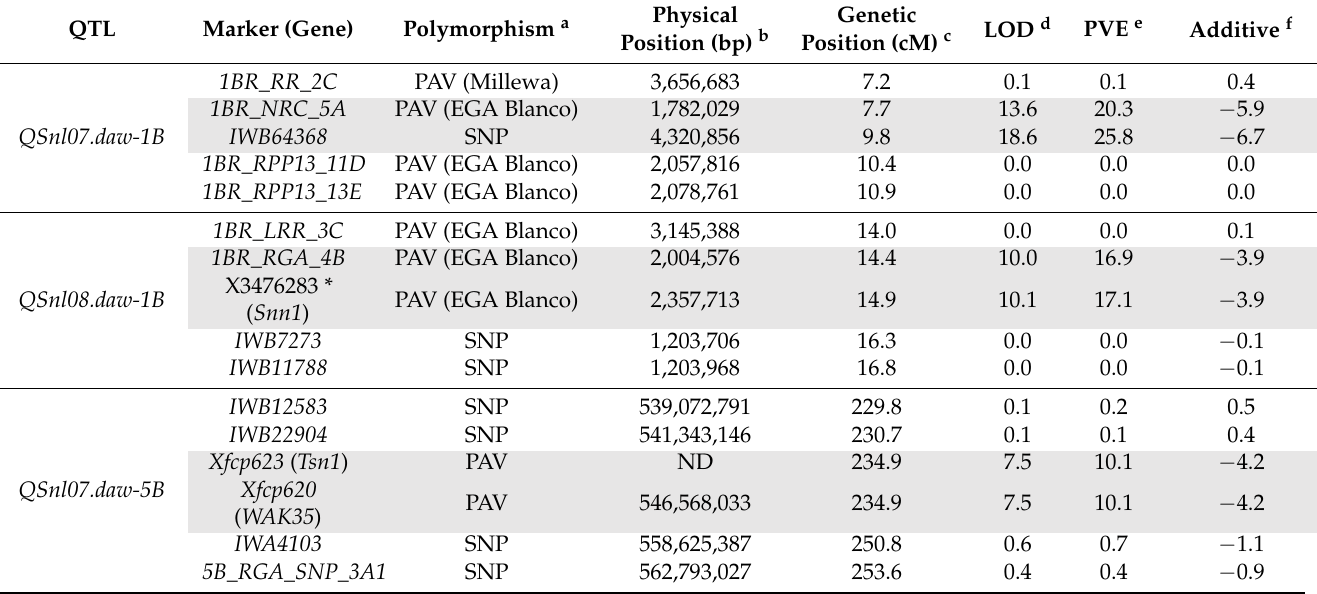
Table 2. One-dimension scanning positions of R -gene markers associated with QTL for SNB resistance in a DH population derived from the cross of resistant and susceptible parents, EGA Blanco and Millewa, respectively. Gene markers with significant associations ( p < 0.001) are highlighted in grey shading.